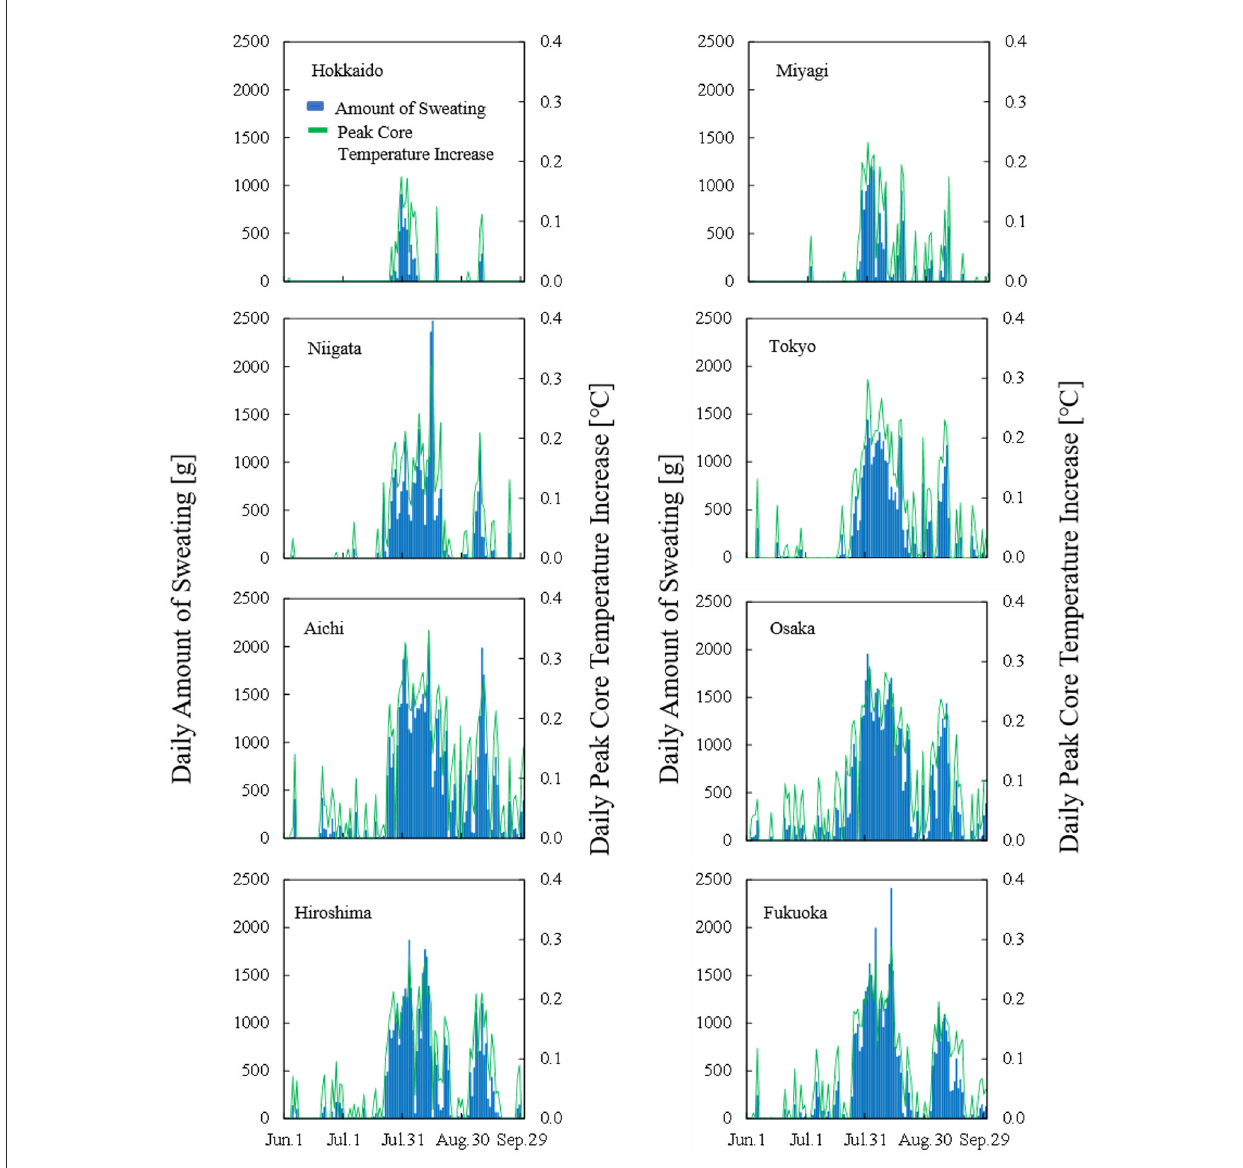
FIGURE2 Time course of computed daily peak core temperature and total amount of sweating in each prefecture in 2019.